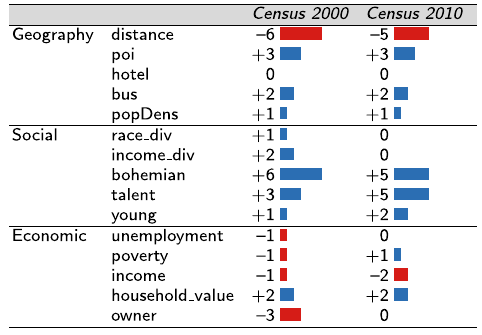
Table 5 Comparison of results obtained by using explanatory variables derived from U.S. census 2000 against results obtained by using U.S. census 2010